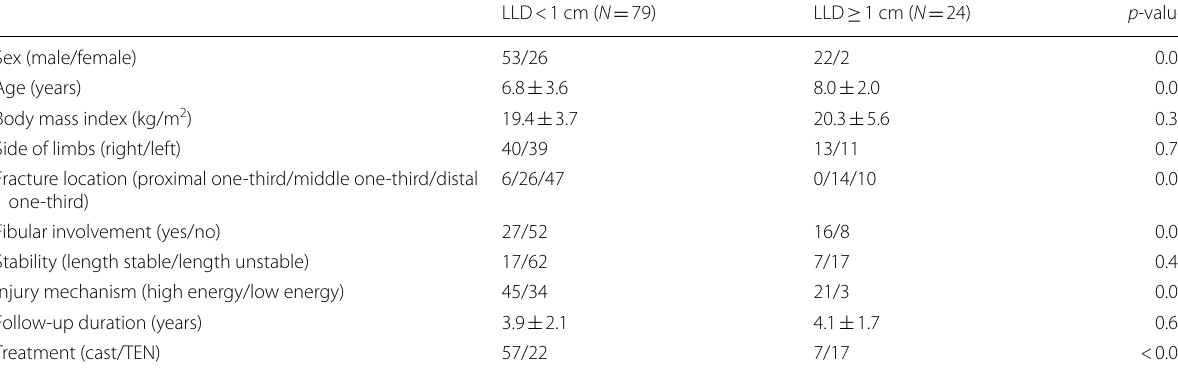
Table 2 Comparison of variables between patients with LLD < 1 cm and those with LLD